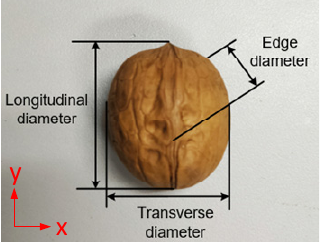
Figure 1. Schematic diagram of walnut diameter.